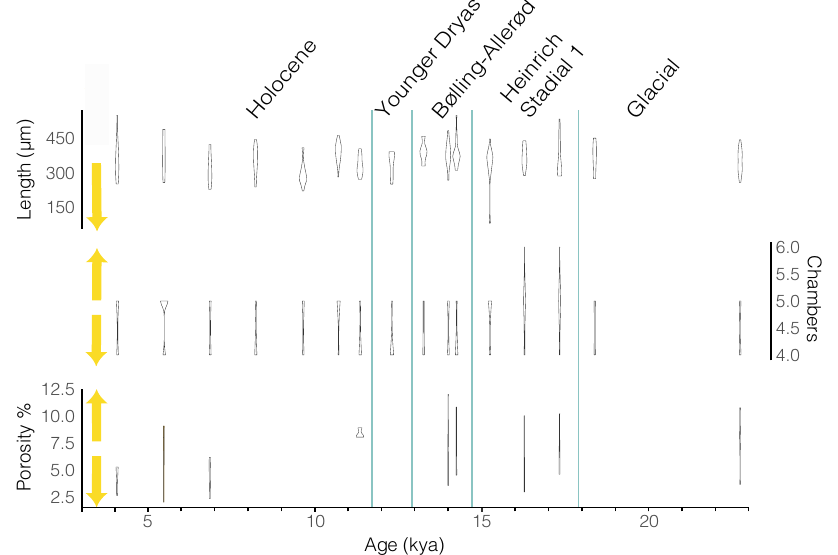
Fig. 2 Violin plots showing the similarities in distribution of morphological traits in populations of G. hexagonus through time. Yellow arrows indicate the directions in which modern data from ETNP plankton tows 38 exceed the range of fossil data in each abrupt decrease in the δ 18 O values of G. hexagonus follows during Heinrich Stadial 1, both independent of and relative to mixed layer G. ruber and thermocline N. dutertrei (Figs. 3, 4). This is interpreted as a shallowing of the mean habitat depth of G.